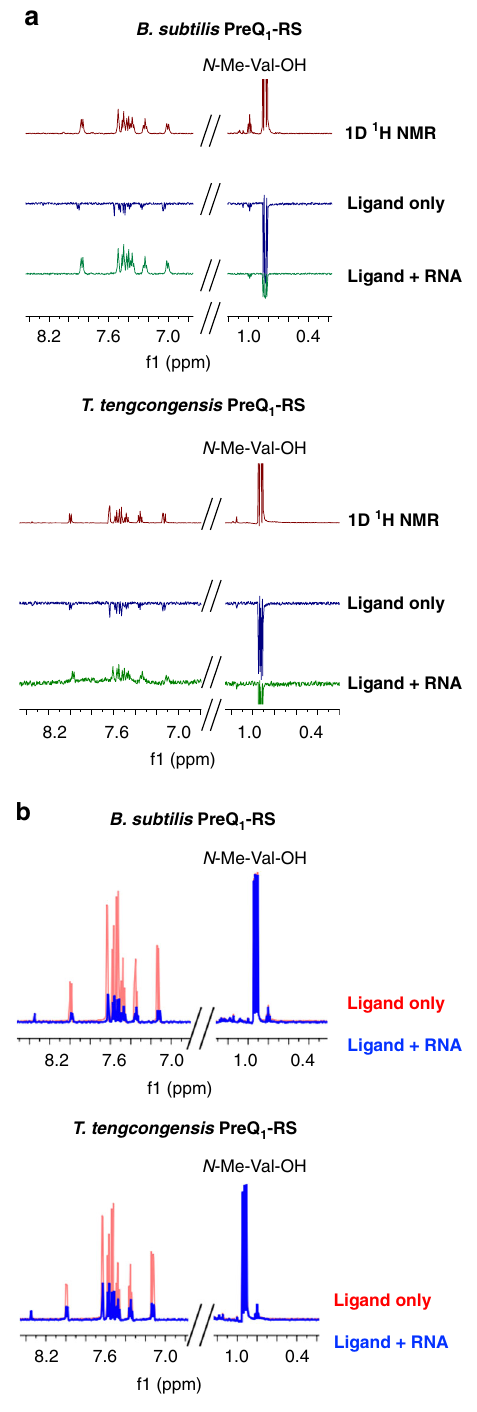
Fig. 2 NMR validation of hit compound 1 . a 1 H NMR of 1 and N -methyl- L - valine (non-binding control) (Top, red spectrum), WaterLOGSY NMR of 1 and N -methyl- L -valine in the absence (middle, blue spectrum) and presence (bottom, green spectrum) of either the Bs or Tt PreQ 1 riboswitch aptamer. b CPMG of 1 and N -methyl- L -valine in the absence (red) and presence (blue) of either the Bs or Tt PreQ 1 riboswitch